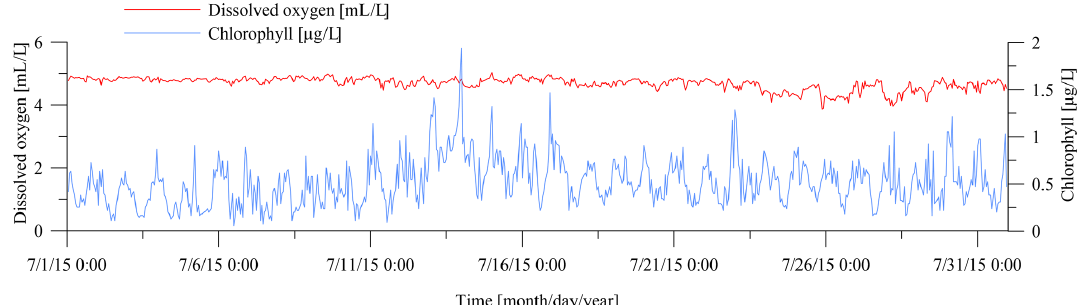
Figure 6. Time series of measured dissolved oxygen [mLL − 1 ] and chlorophyll [µgL − 1 ] in July 2015. Time is local time.